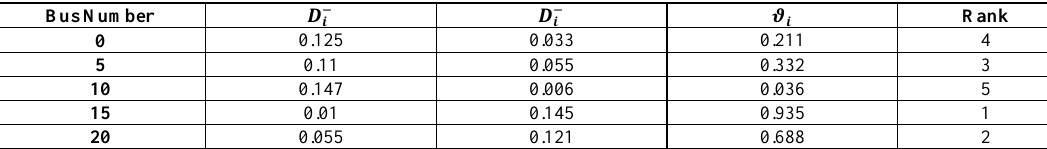
Table 6. Separation distance, relative closeness & rank.